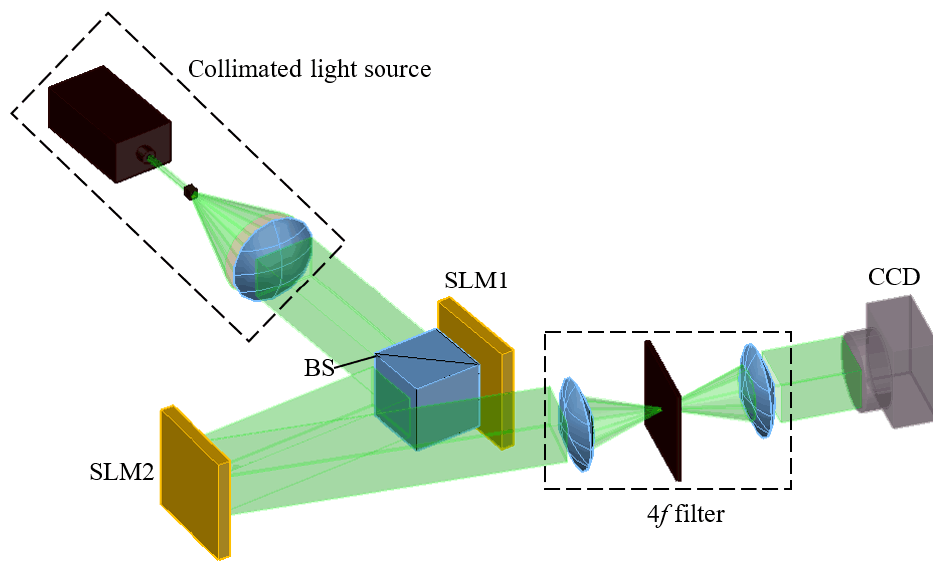
Figure 1. Structure of the proposed system.